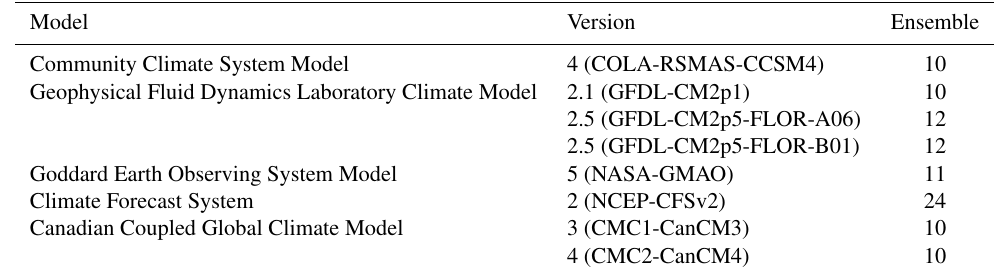
Table 1. List of NMME models used in this study.